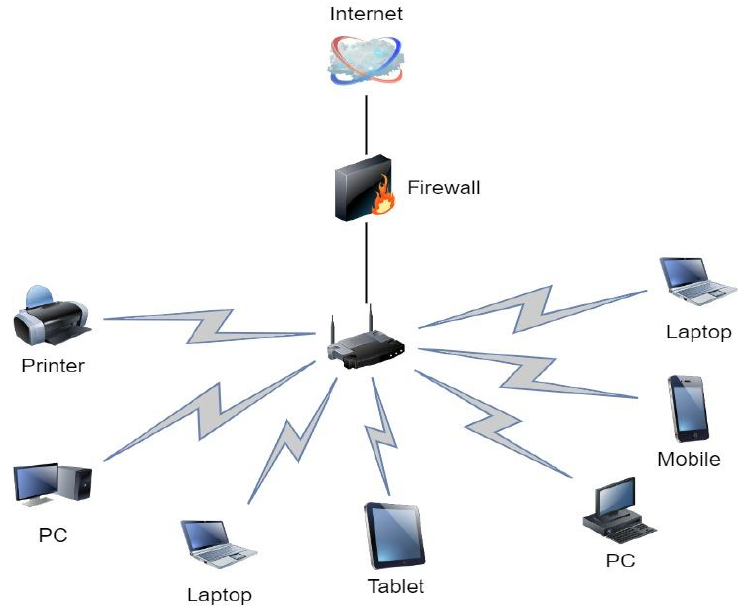
Figure 8. A sample of wireless networks.